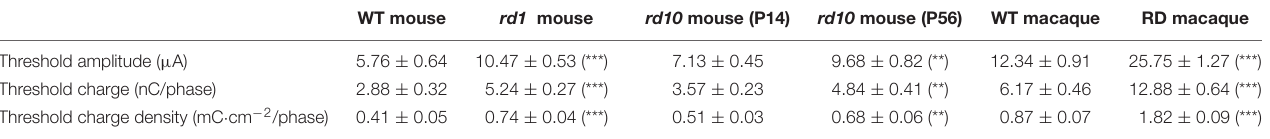
TABLE 1 | Comparison of threshold amplitude, threshold charge, and threshold charge density between control and RD groups. WT mouse rd1